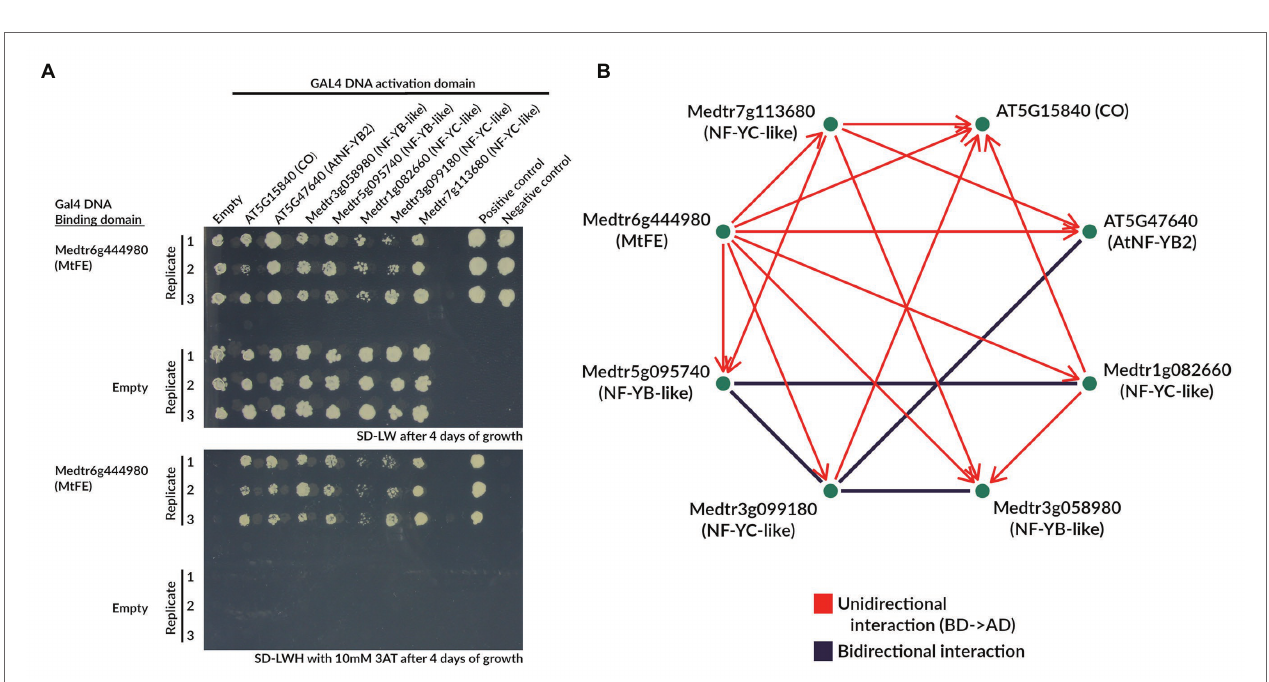
FIGURE 6 | MtFE interacts with NF-Y-like proteins in yeast two-hybrid assays. (A) is an example of the yeast growth observed in an Y2H assay when MtFE was fused to the GAL4 DNA BD, and CO and NF-Y-like proteins were fused to the GAL4 activation domain (AD). Two photographs are shown, one on SD-LW media (upper panel), and the other on SD-LWH + 2 mM 3AT media (lower panel) selecting for yeast two-hybrid interactions. All assays were plated in triplicate. Also included are empty vector controls. (B) is a network summarizing the total observed interactions after 10 days of growth at 10 mM 3AT, excluding CO fused to the BD which showed auto-activation. Interactions only observed in one configuration of the GAL4 domains are in red and arrows extend from the protein fused to the BD to the protein fused to the AD. Bidirectional interactions (either configuration of GAL4 domains) are depicted in